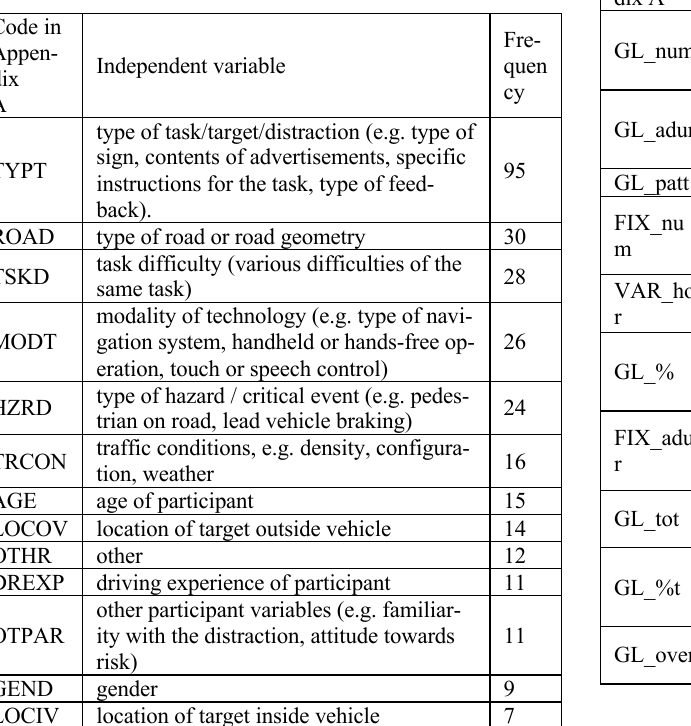
Table 4. Frequency of used independent variables.